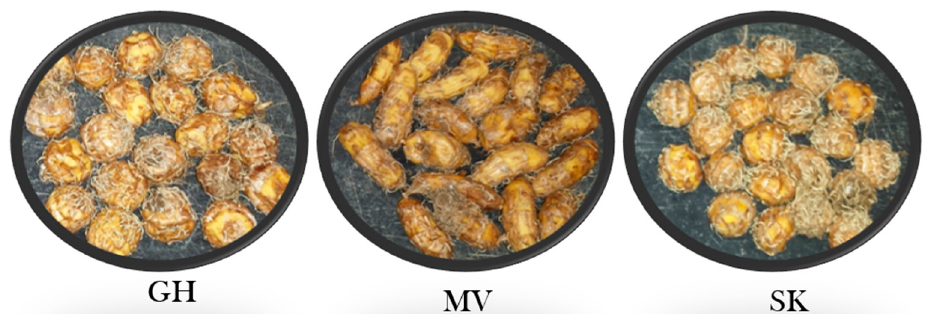
Figure 6. Tuber size and shape in the GH, MV, and SK tigernut selections grown in the hoop house using Pro-Mix BX brand. Tubers were harvested 14 weeks after planting (See Table 1 for a full description of acronyms) (Photos: Albert Ayeni).